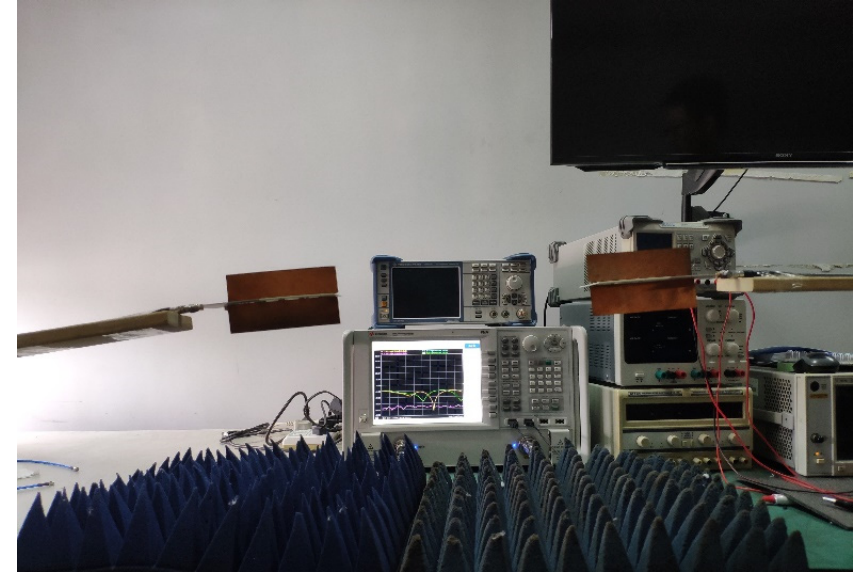
Figure 14. The measurement setup for the phase and magnitude difference.